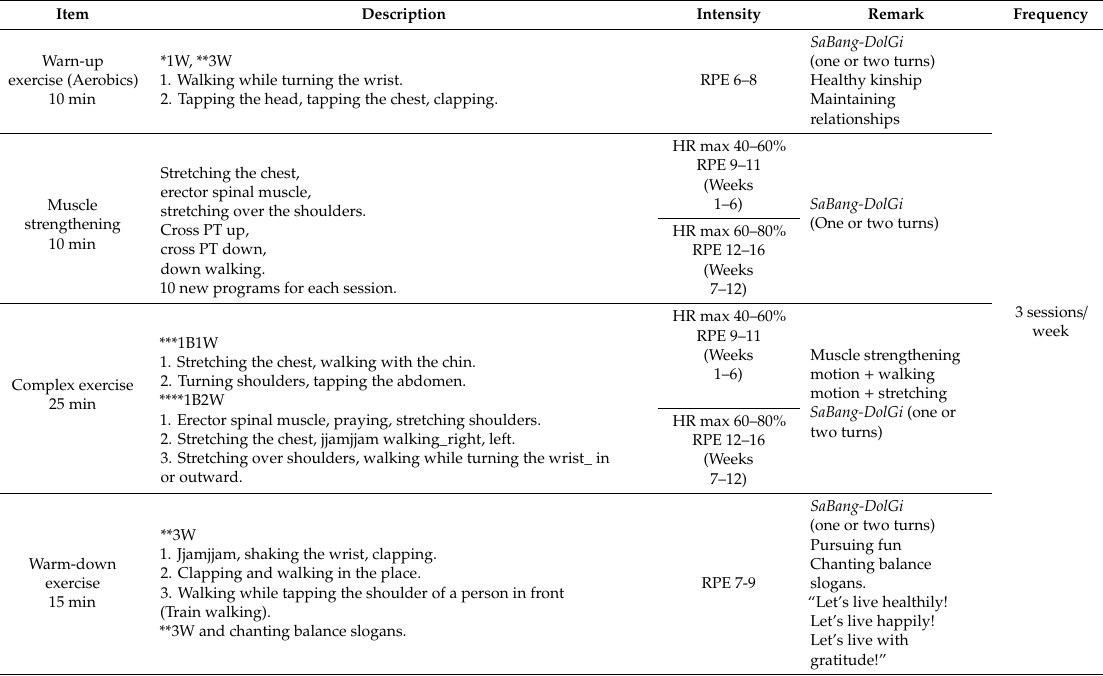
Table 3. SaBang-DolGi walking exercise